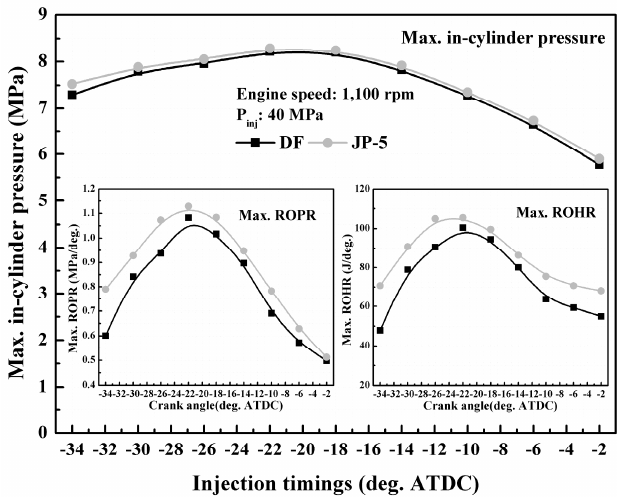
Figure 5. Max. in-cylinder pressure, ROHR, and ROPR characteristics with injection timings .